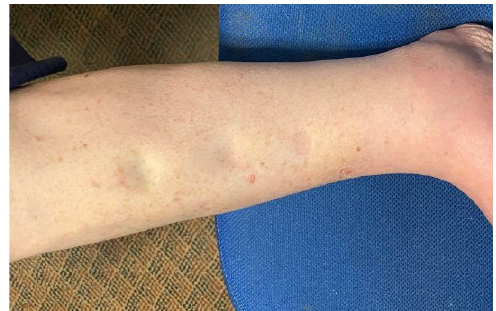
Figure 1. Extent of pitting edema in calf prior to DTM. Massage technique used